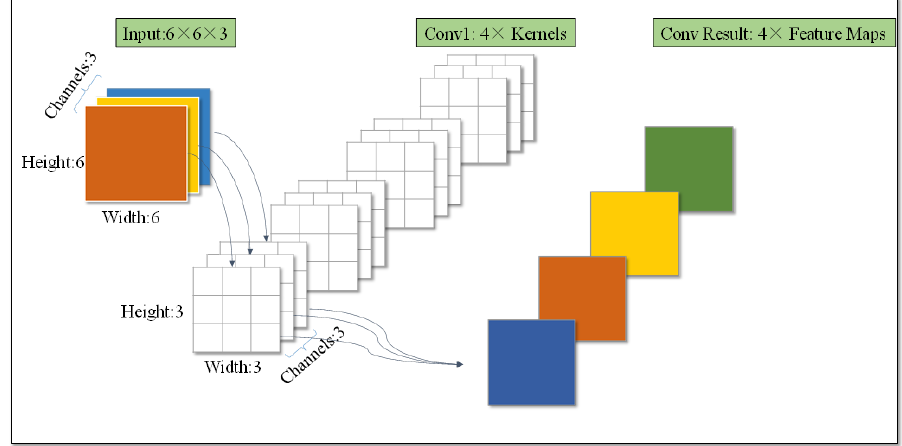
Figure 1. Schematic diagram of the convolutional layer.